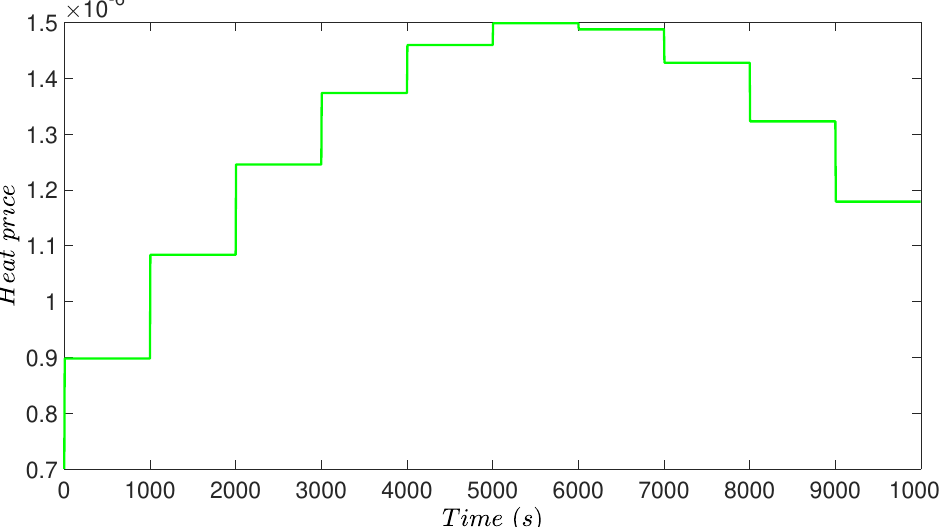
Figure 4. Heat price profile during the simulation, where the heat price first increases and then decreases to simulate heat rate price changing.